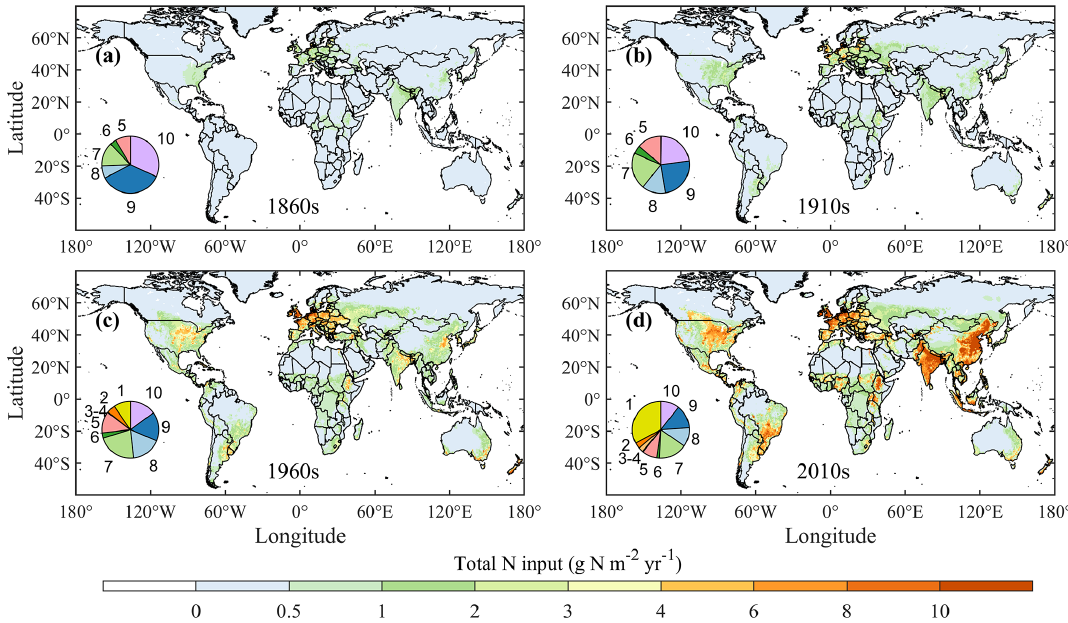
Figure 5. Spatial patterns in total N input in the (a) 1860s, (b) 1910s, (c) 1960s, and (d) 2010s. For the inset pie charts, the numbers 1 to 10 represent the percentage of each respective component: 1 – NH + 3 – NH + -N fertilizer applied to pasture, 4 – NO − 4